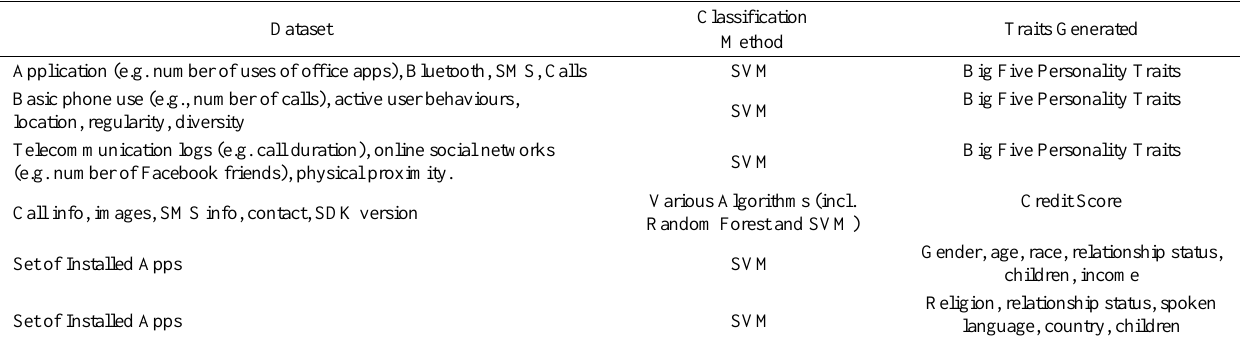
Table 3. Studies about user identification traits using smartphone usage